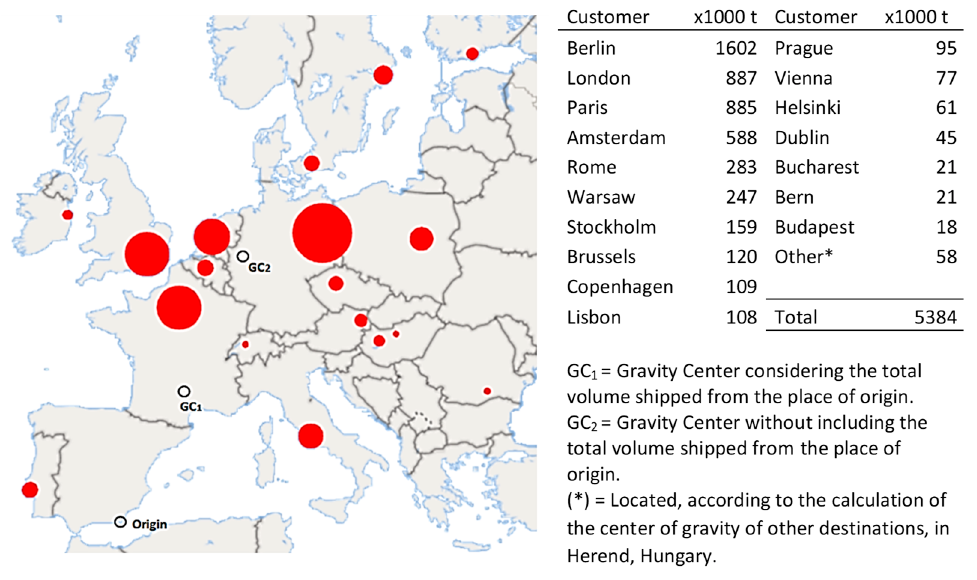
Figure 2. Main customers of fruit and vegetable exportation from southeast Spain. Source: own elaboration.